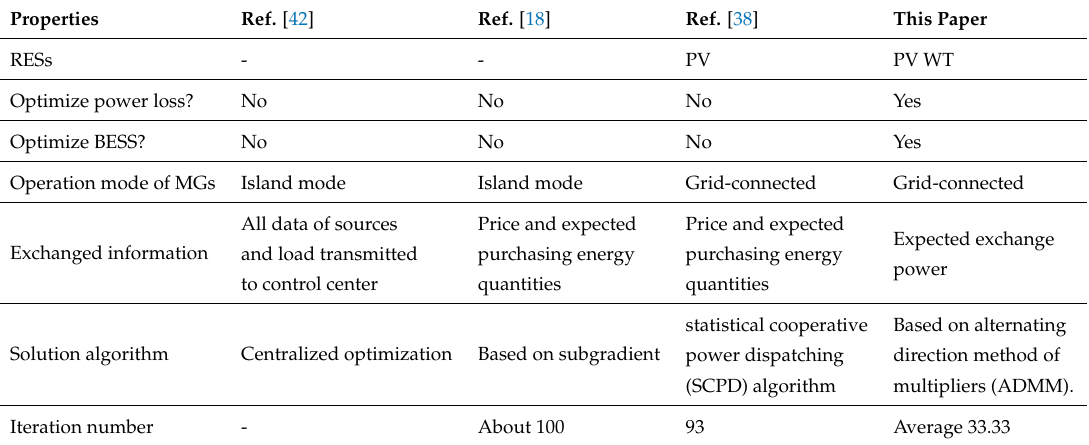
Table 8. Comparison with several related